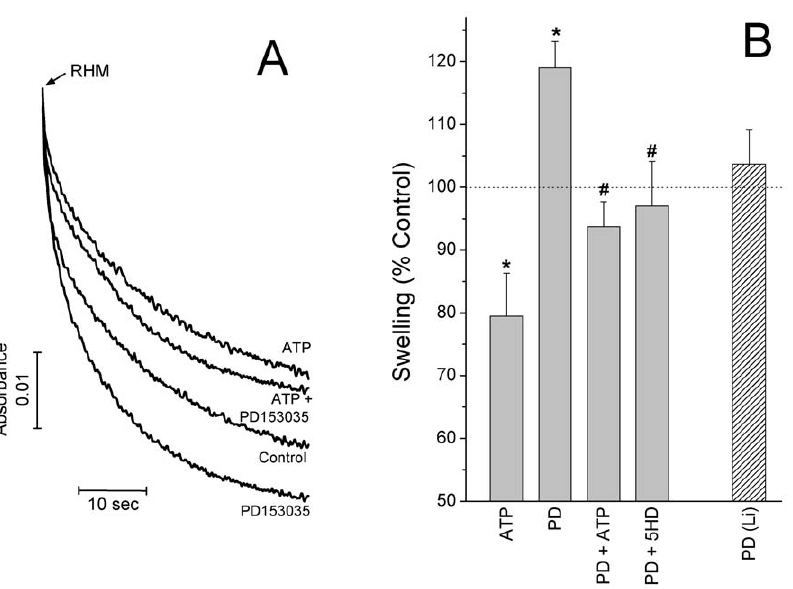
Figure 5. PD153035 increases mitochondrial ATP-sensitive K + transport. Isolated rat heart mitochondria (RHM; 0.5 mg/mL) were suspended in 100 mM KCl, 5 mM HEPES, 2 mM P i , 1 mM MgCl 2 , 0.1 mM EGTA, 1 m g/mL oligomycin and 10 mM succinate, pH 7.4 (KOH), and light scattering changes were recorded over the first 40 seconds. Where indicated, 200 m M ATP, 10 nM PD153035, 20 m M DZX and/or 60 m M 5-HD were present. Control experiments were conducted in the presence of the equivalent concentration of PD153035 solvent DMSO (0.1%). Panel A depicts representative traces, while Panel B shows average 6 SEM swelling relative to control of 8 experimental repetitions. The hatched column represents an experiment in which KCl was substituted by LiCl. * p , 0.01 versus control; # p , 0.01 versus PD. The effect of PD153035 in Li + media was compared to swelling in Li + media in the absence of this drug. Incubations in Li + media resulted in 88.6 6 4.0% of the swelling observed in K + media.